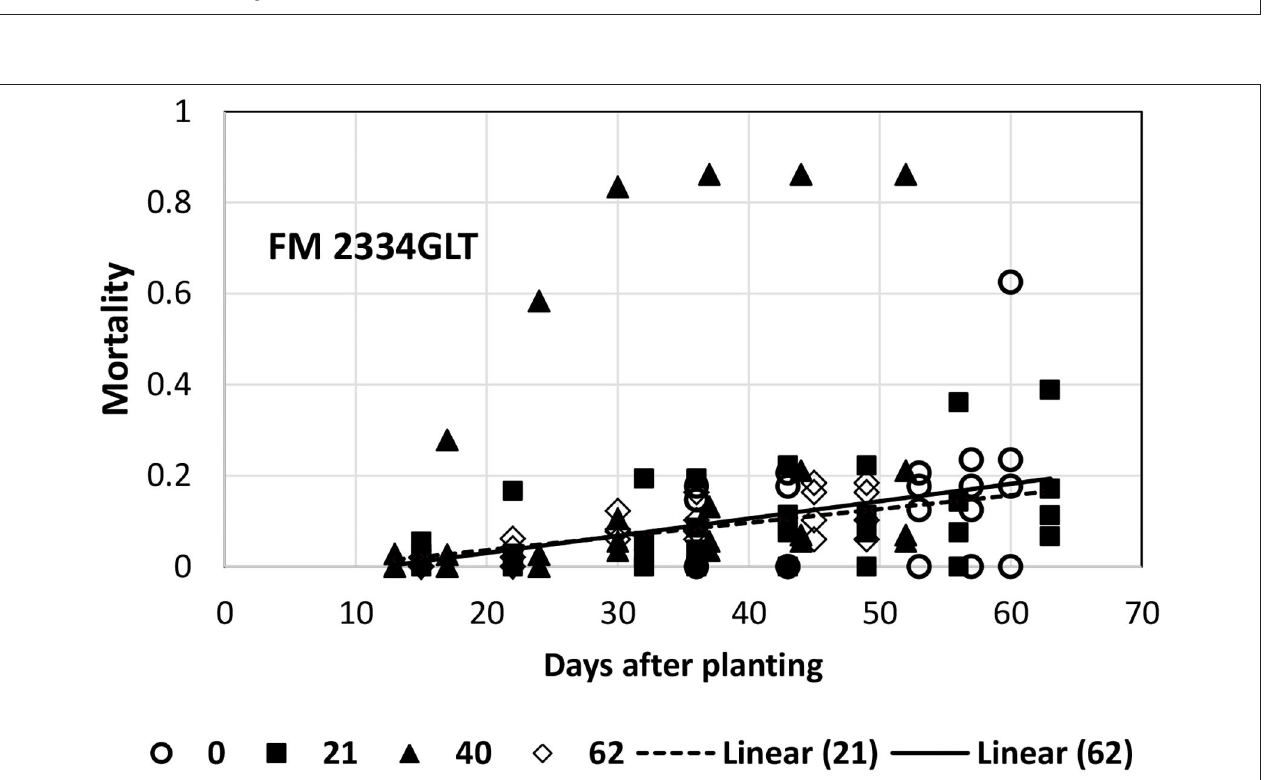
FIGURE 5 | Proportion of plants that emerged and then died (mortality) over time for FM 2334GLT at planting times of day 0, 21, 40, and 62 (day 0 occurred on 16 April) in 2021. Linear models were fitted for day 21 and 62 planting dates.